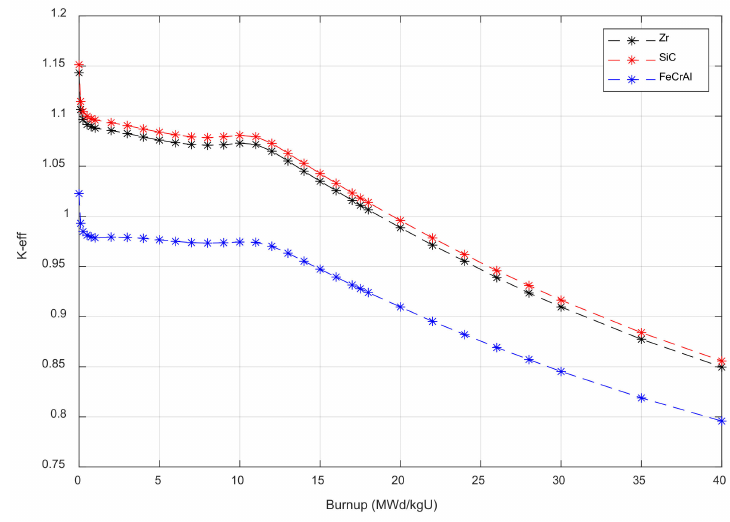
Figure 13. Effective multiplication factor versus burnup days for APR-1400 reactor